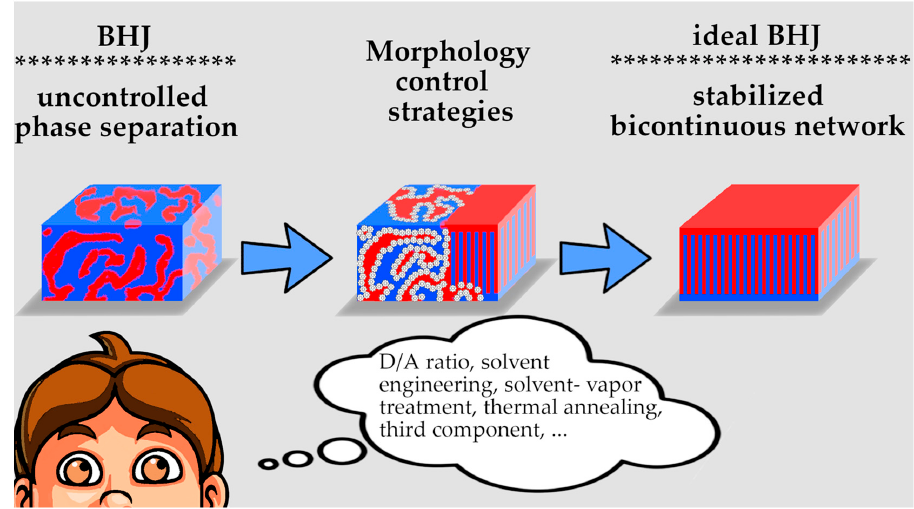
Figure 1. Pictorial representation of a bulk heterojunction. As suggested by Tommy, several strategies can be adopted, aiming at controlling the morphological profile at the microscale nanoscale and bring- ing the system closer to the ideal